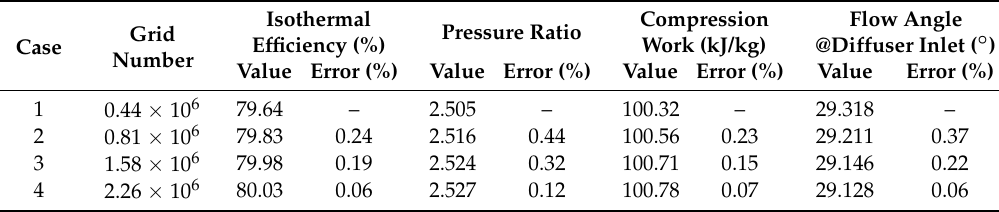
Table 1. Grid Independence Validation.